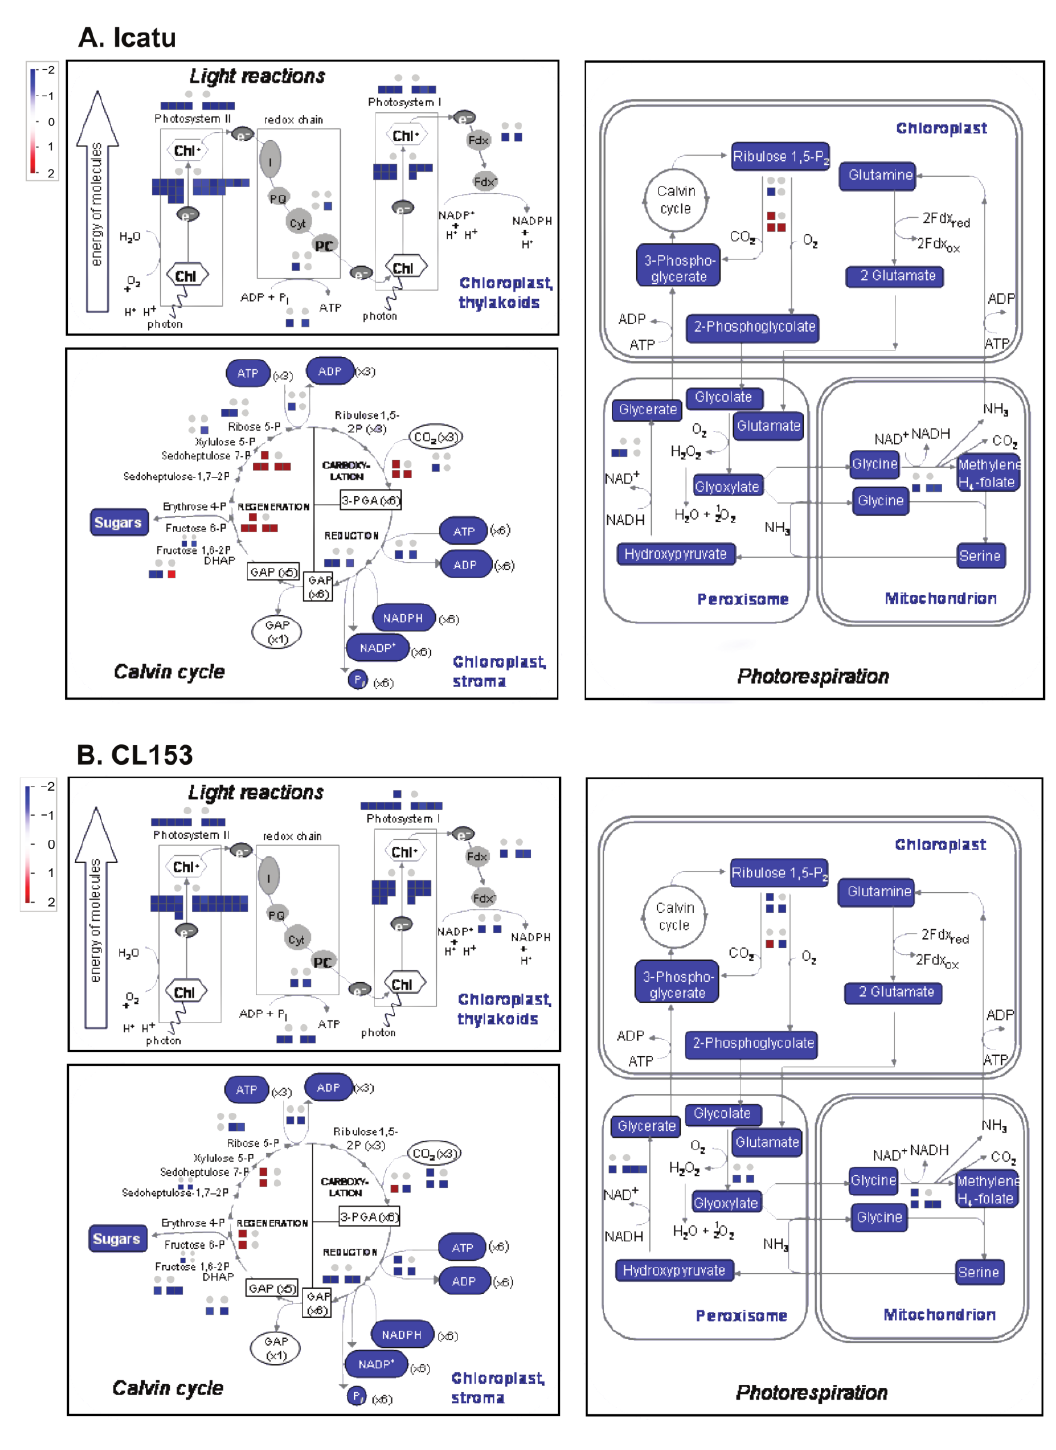
Figure 4. Changes in the expression of photosynthesis-related DEGs in ( A ) Icatu and ( B ) CL153 plants grown under MWD or SWD in comparison with WW plants grown under aCO 2 or eCO 2 , at 25/20 °C (day/night). Pathway diagrams of light reactions of photosynthesis, the Calvin cycle, and photorespiration with superimposed color-coded squares drawn in MapMan. The color scale represents the level of regulation (blue: down-regulated DEGs; red: up-regulated DEGs). Results in the squares are presented in the following order: top left — MWD-aCO 2 ; top right — MWD-eCO 2 ; bottom left — SWD-aCO 2 ; bottom right — SWD-eCO 2 . Grey dots represent an absence of DEGs. An absence of data in eCO 2 indicates the absence of DEGs.